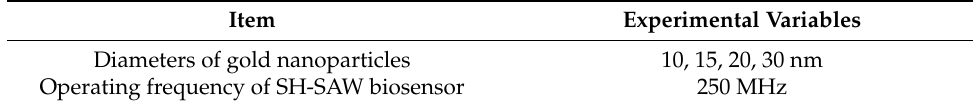
Table 1. Experimental